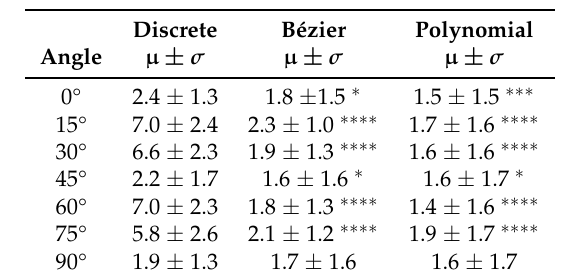
Table 8. Mean relative error of the length measurement methods in % after the centerline extraction by erosion and the spatial interpolation compared to the ground truth for the experimental data set. Significance was proven for the reduction of the error compared to the discrete length as indicated ∗ p < 0.05, ∗∗∗ p < 0.001, ∗∗∗∗ p < 0.0001.